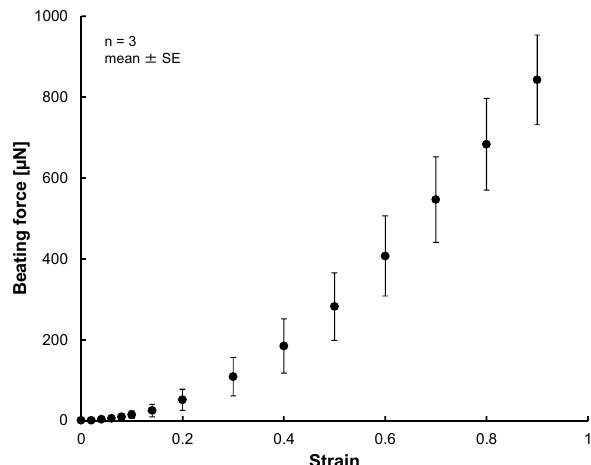
Figure 8. Photos of the cardiac 3D tissue during the tensile test.